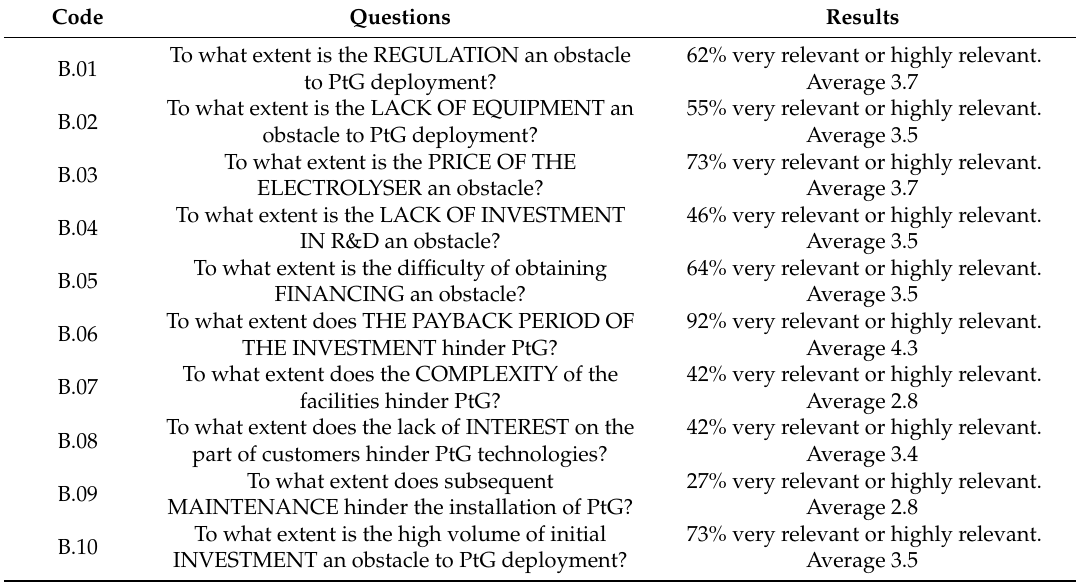
Table 2. Results of the experts’ interviews regarding barriers to power-to-gas (PtG).